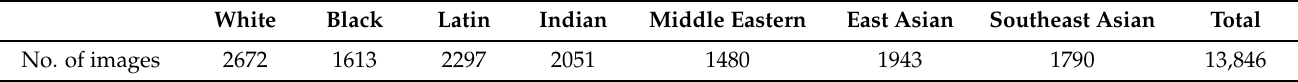
Table 9. Distribution of images by ethnicity in the FairFace filtered testing set.